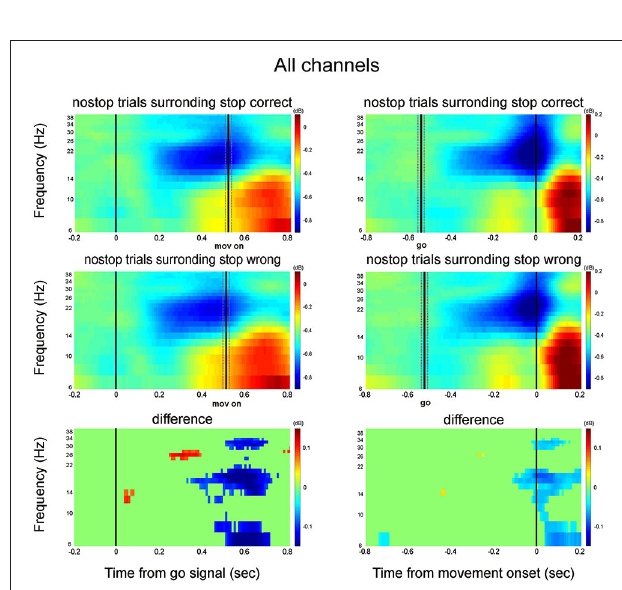
FIGURE 10 | Grand average time-frequency plot across all channels . Other conventions as in Figure 9